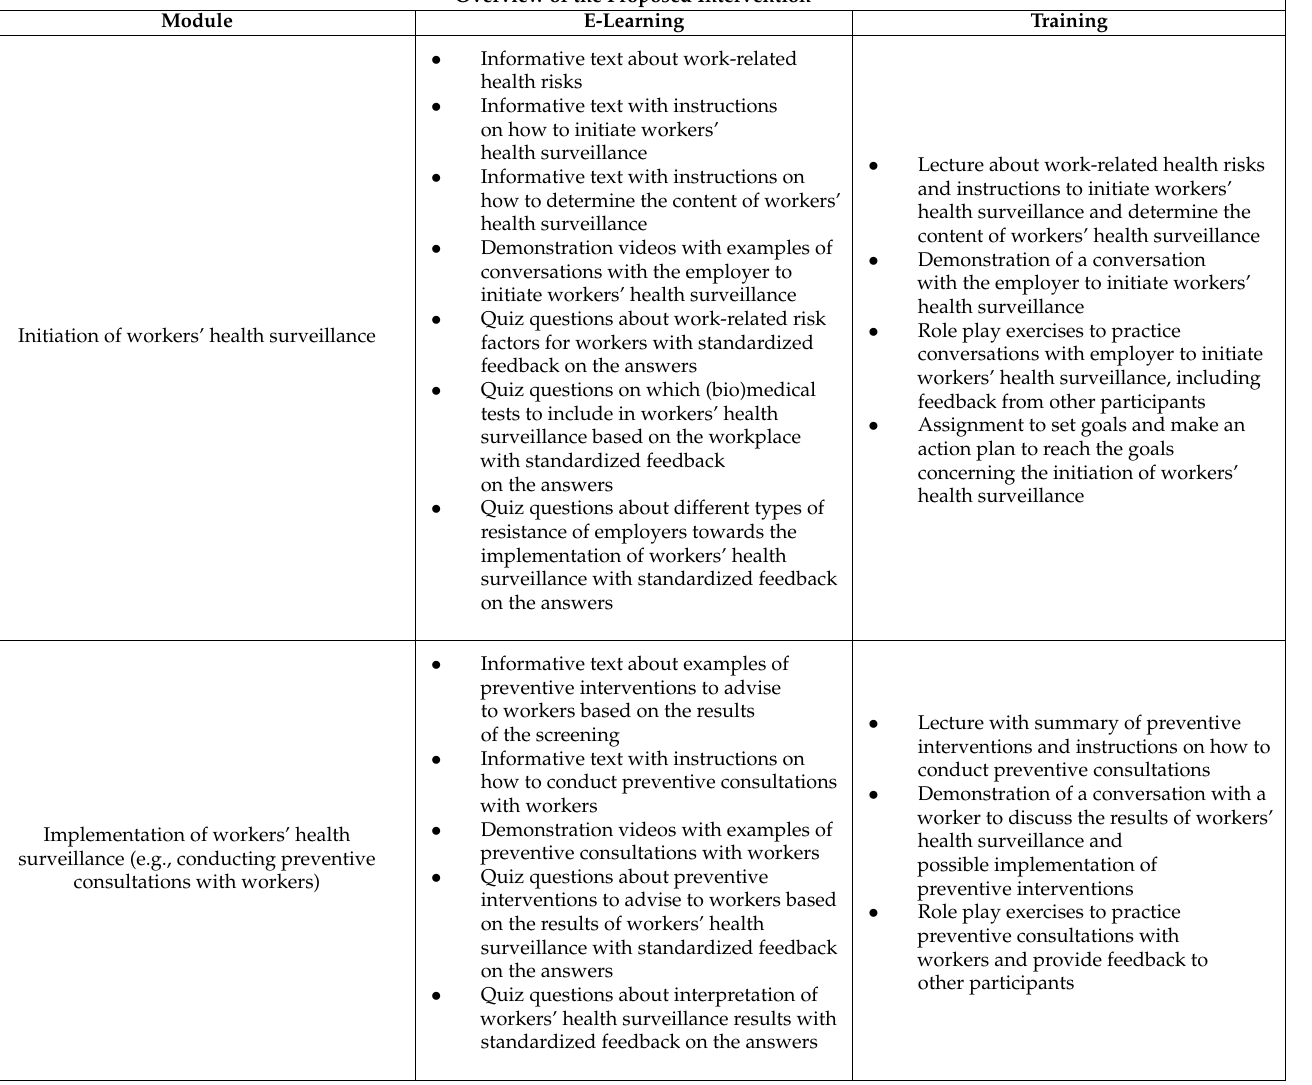
Table 2. Overview of the proposed